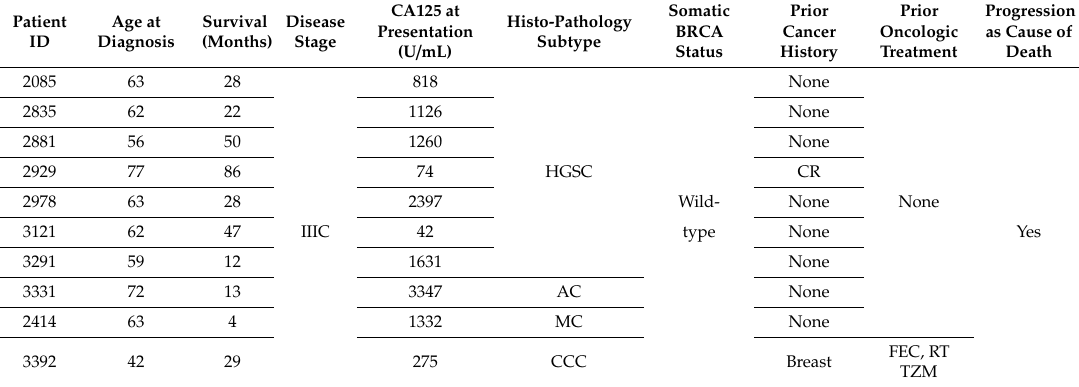
Table 1. Clinical characteristics of patients from whom cell lines were